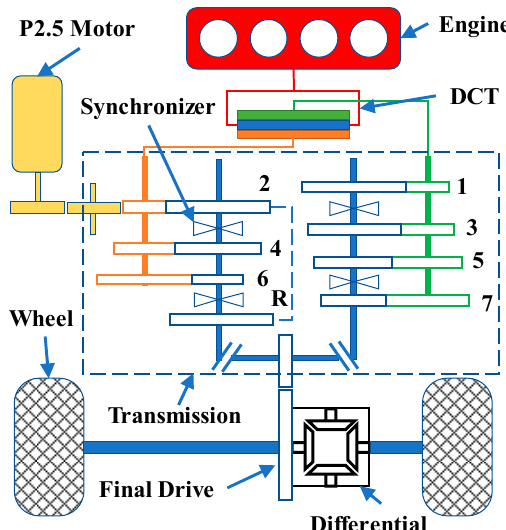
Figure 1. The structure diagram of the P2.5-PHEVs system (The numbers indicate the